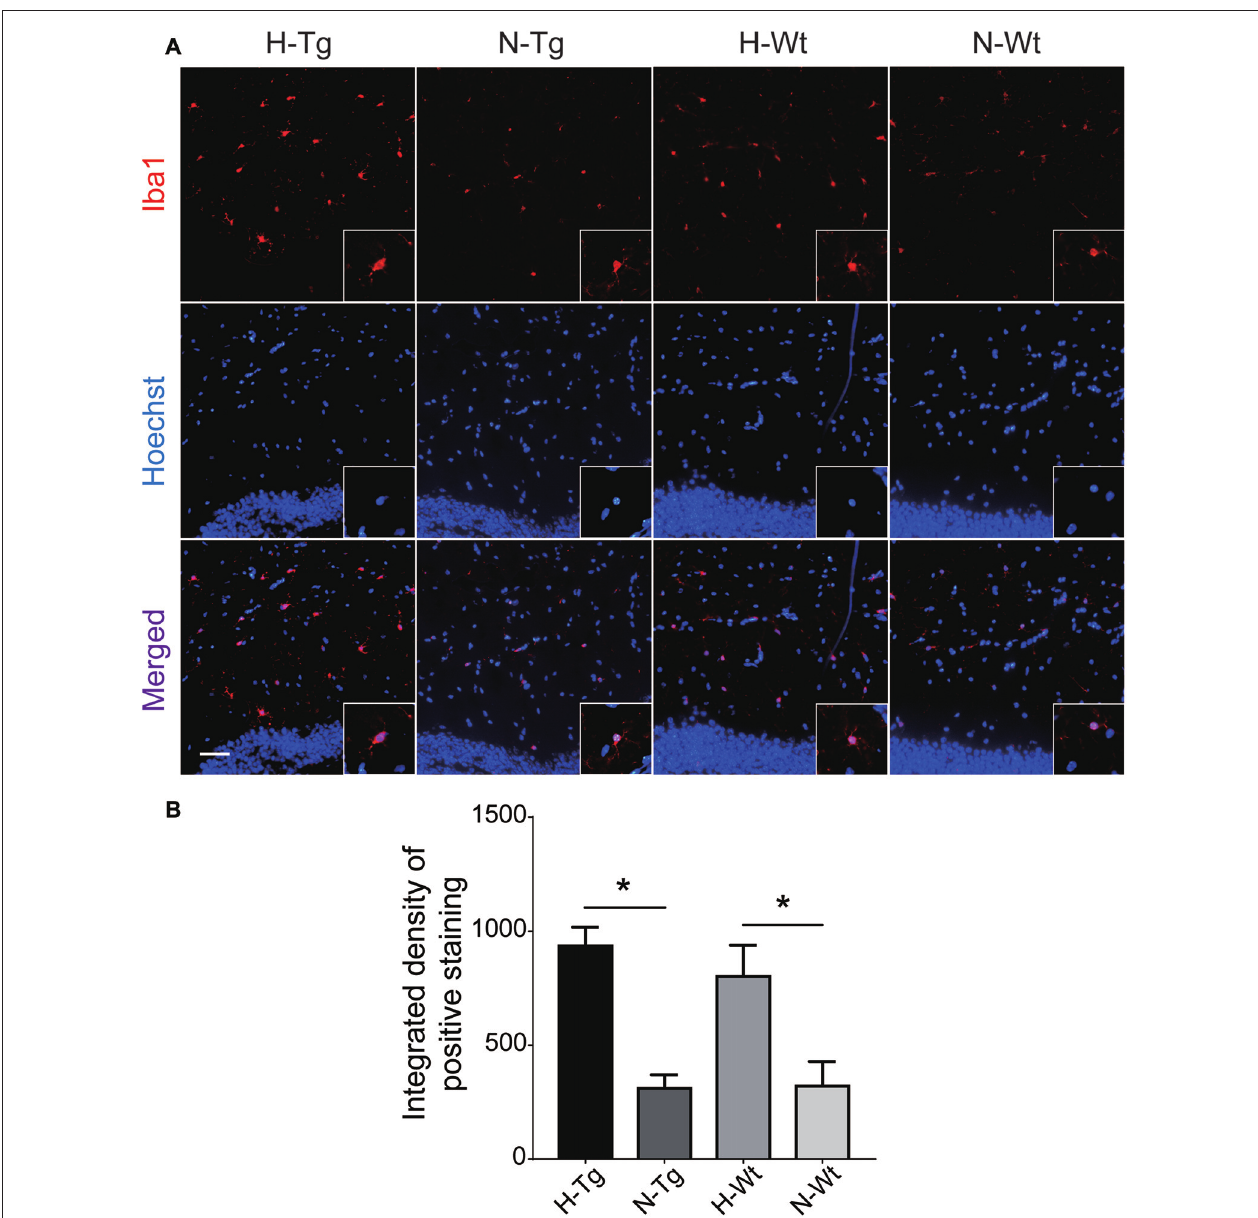
FIGURE 1 | Immunoflourescence staining of microglia cells in mouse hippocampus after acute hypoxia. Microglia were detected by ionized calcium binding adapter molecule 1 (Iba1) antibody (A) . Iba1 positive staining was increased in H-Tg and H-Wt groups vs. N-Tg and N-Wt groups, respectively (B) . Scale bar: 50 µ m, n = 3 in each group. Data were the mean ± standard error of the mean (SEM) values. ∗ p < 0.05 by one-way analysis of variance